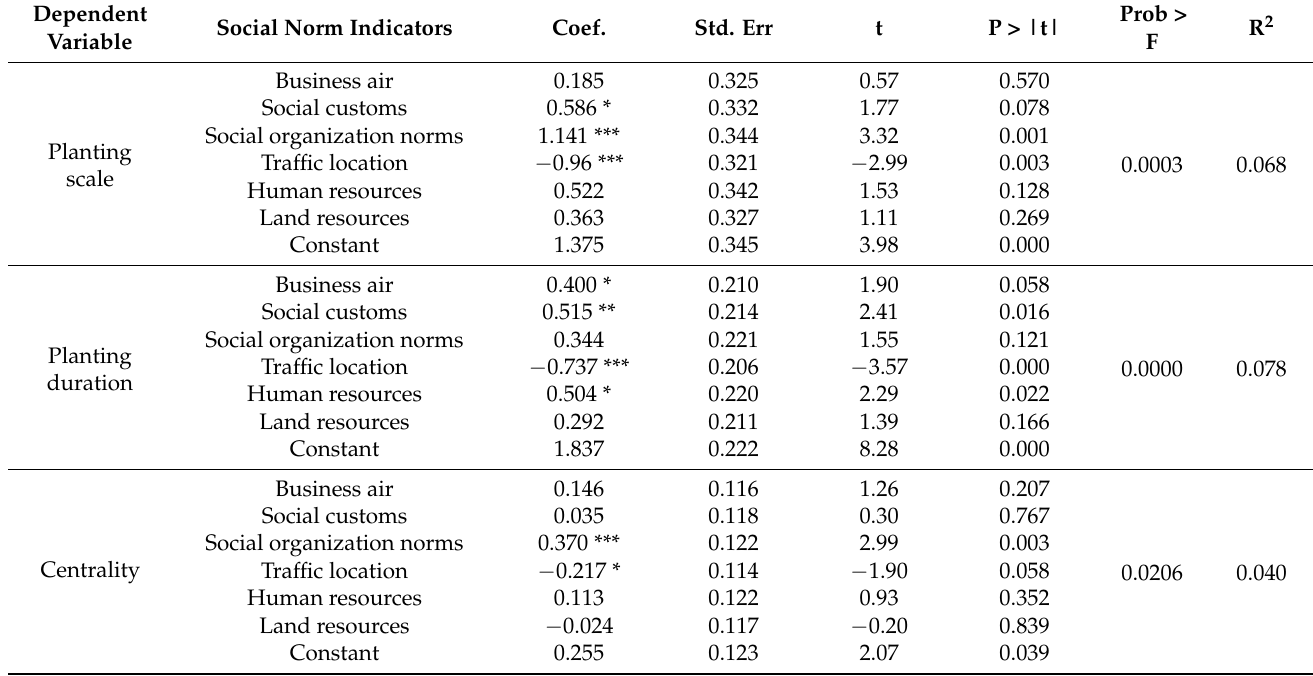
Table 4. Impact of social norms on grape planting in village.